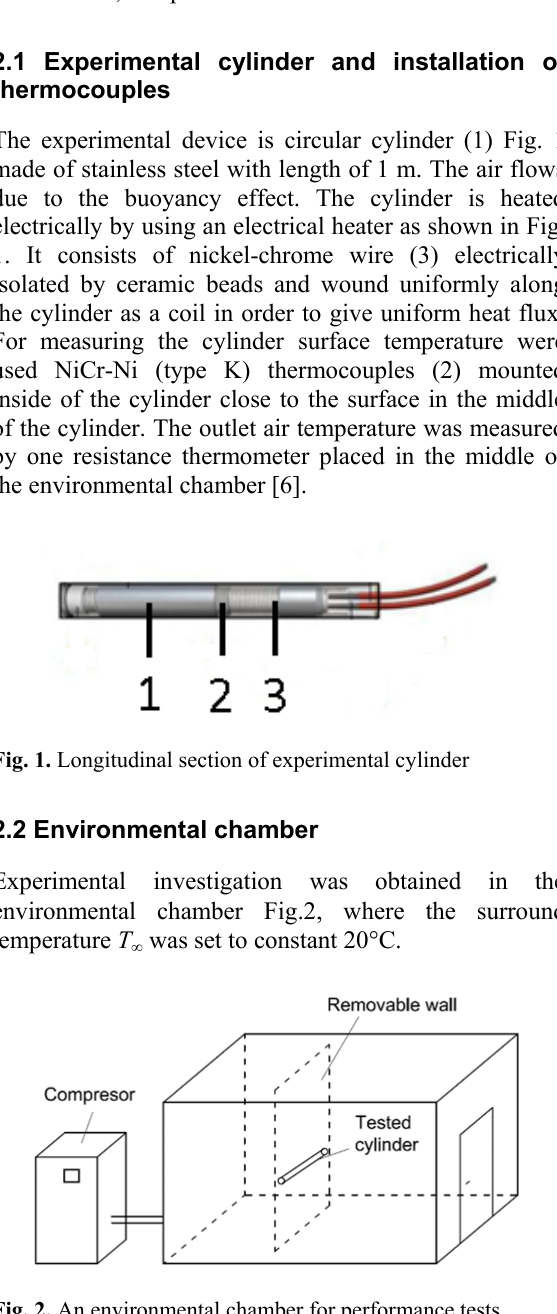
Fig. 2. An environmental chamber for performance tests